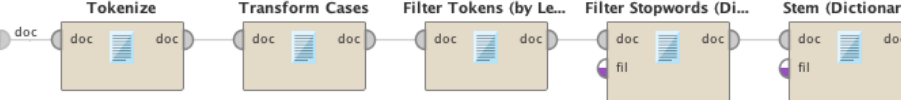
Figure 3. Document processing module (news)